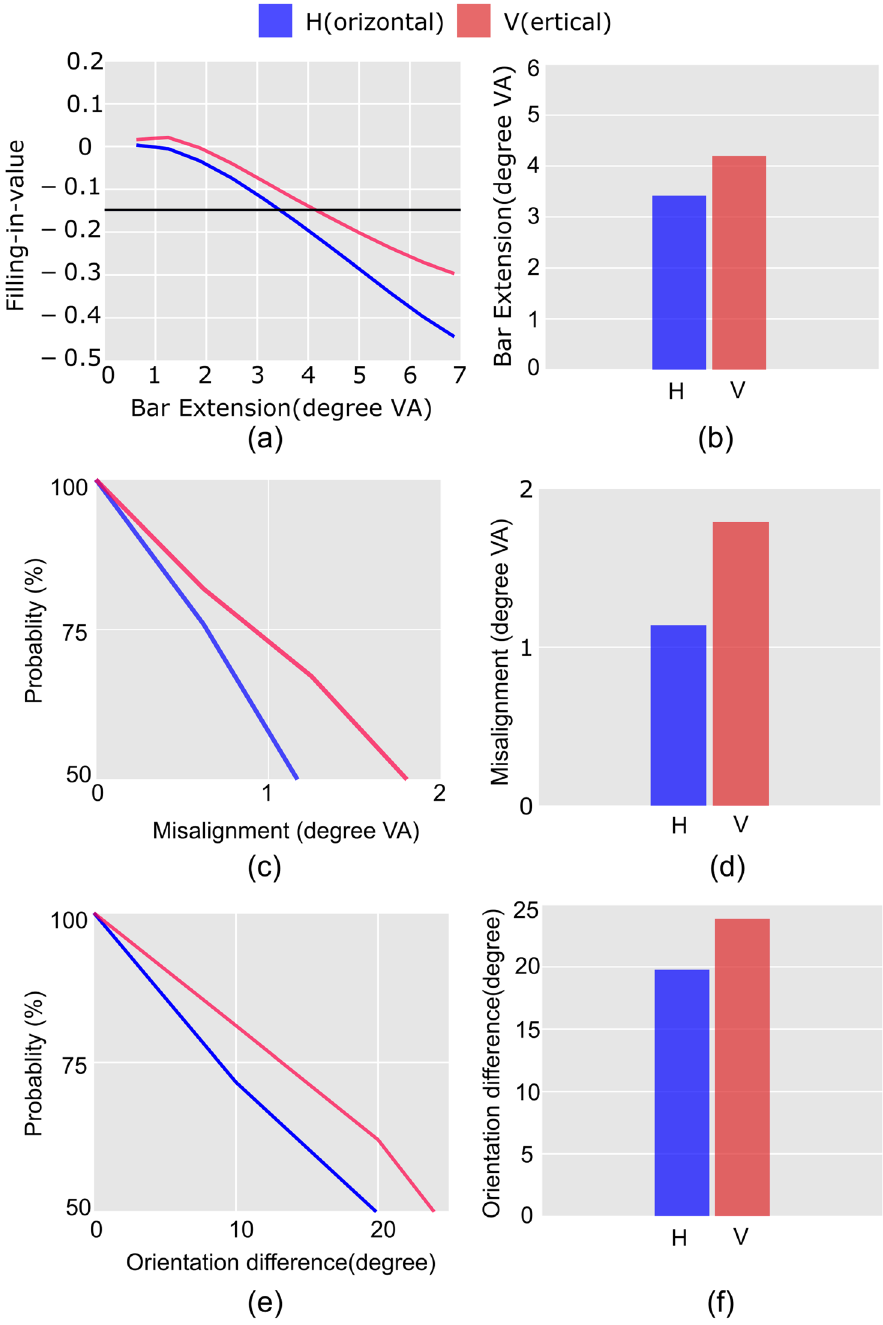
Figure 7. Comparison with psychophysical results. Results of Figs 4b, 5b and 6b are redrawn in ( a ), ( c ) and ( e ) respectively for the comparison. The visual angle is represented as VA in the plots. ( a ) The horizontal line represents the threshold corresponding to the 50% of the maximum filling-in-value for vertical configuration, and the estimated bar lengths corresponding to this threshold are plotted as bars in ( b ). ( c ) Normalized plots, as explained in the text, for the positive misalignments are presented, which continued from the 100% to 50% probability (artificial threshold). The amount of misalignment at this threshold for the horizontal and vertical cases are shown as bars in ( d ). ( e ) Similar normalized plots for orientation difference are shown here and estimated orientation difference at 50% threshold is shown as bar plots in ( f